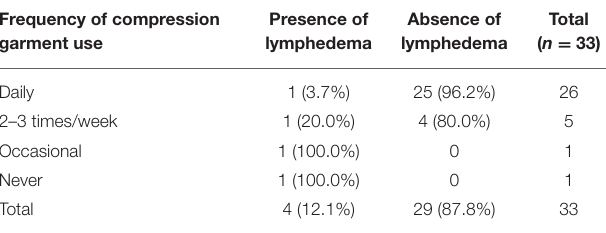
TABLE 6 | Lymphedema in the experimental arm as a function of frequency of CG use in the first 3